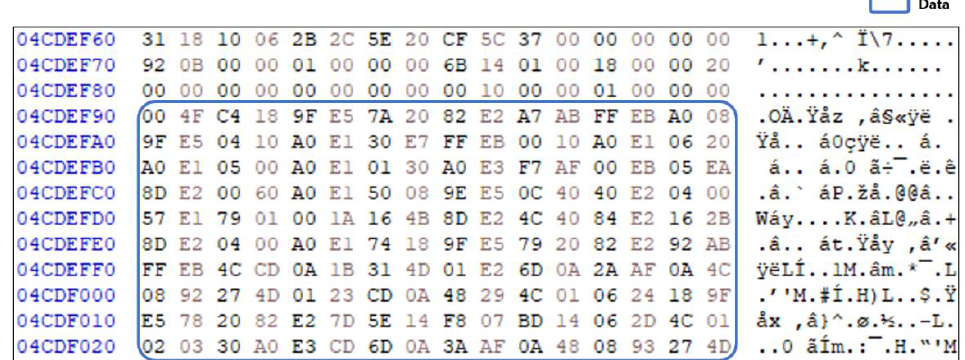
Figure 26. Encrypted data area in dcu.tar file.